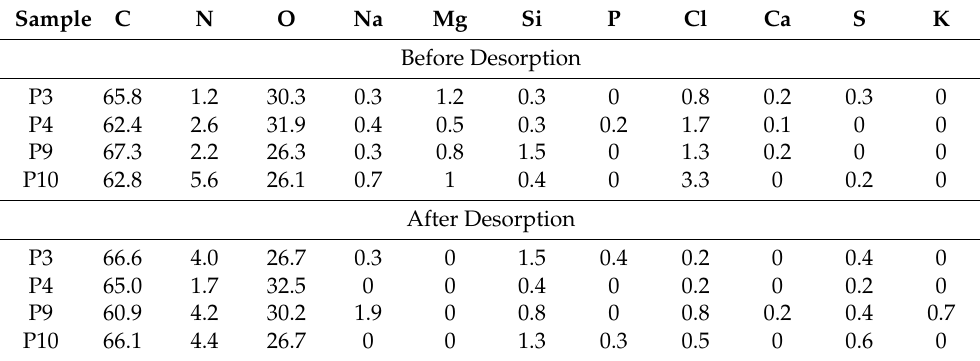
Table 6. XPS analysis of functionalized PLA films with P. pavonica extract before and after desorption (in %). Sample C N O